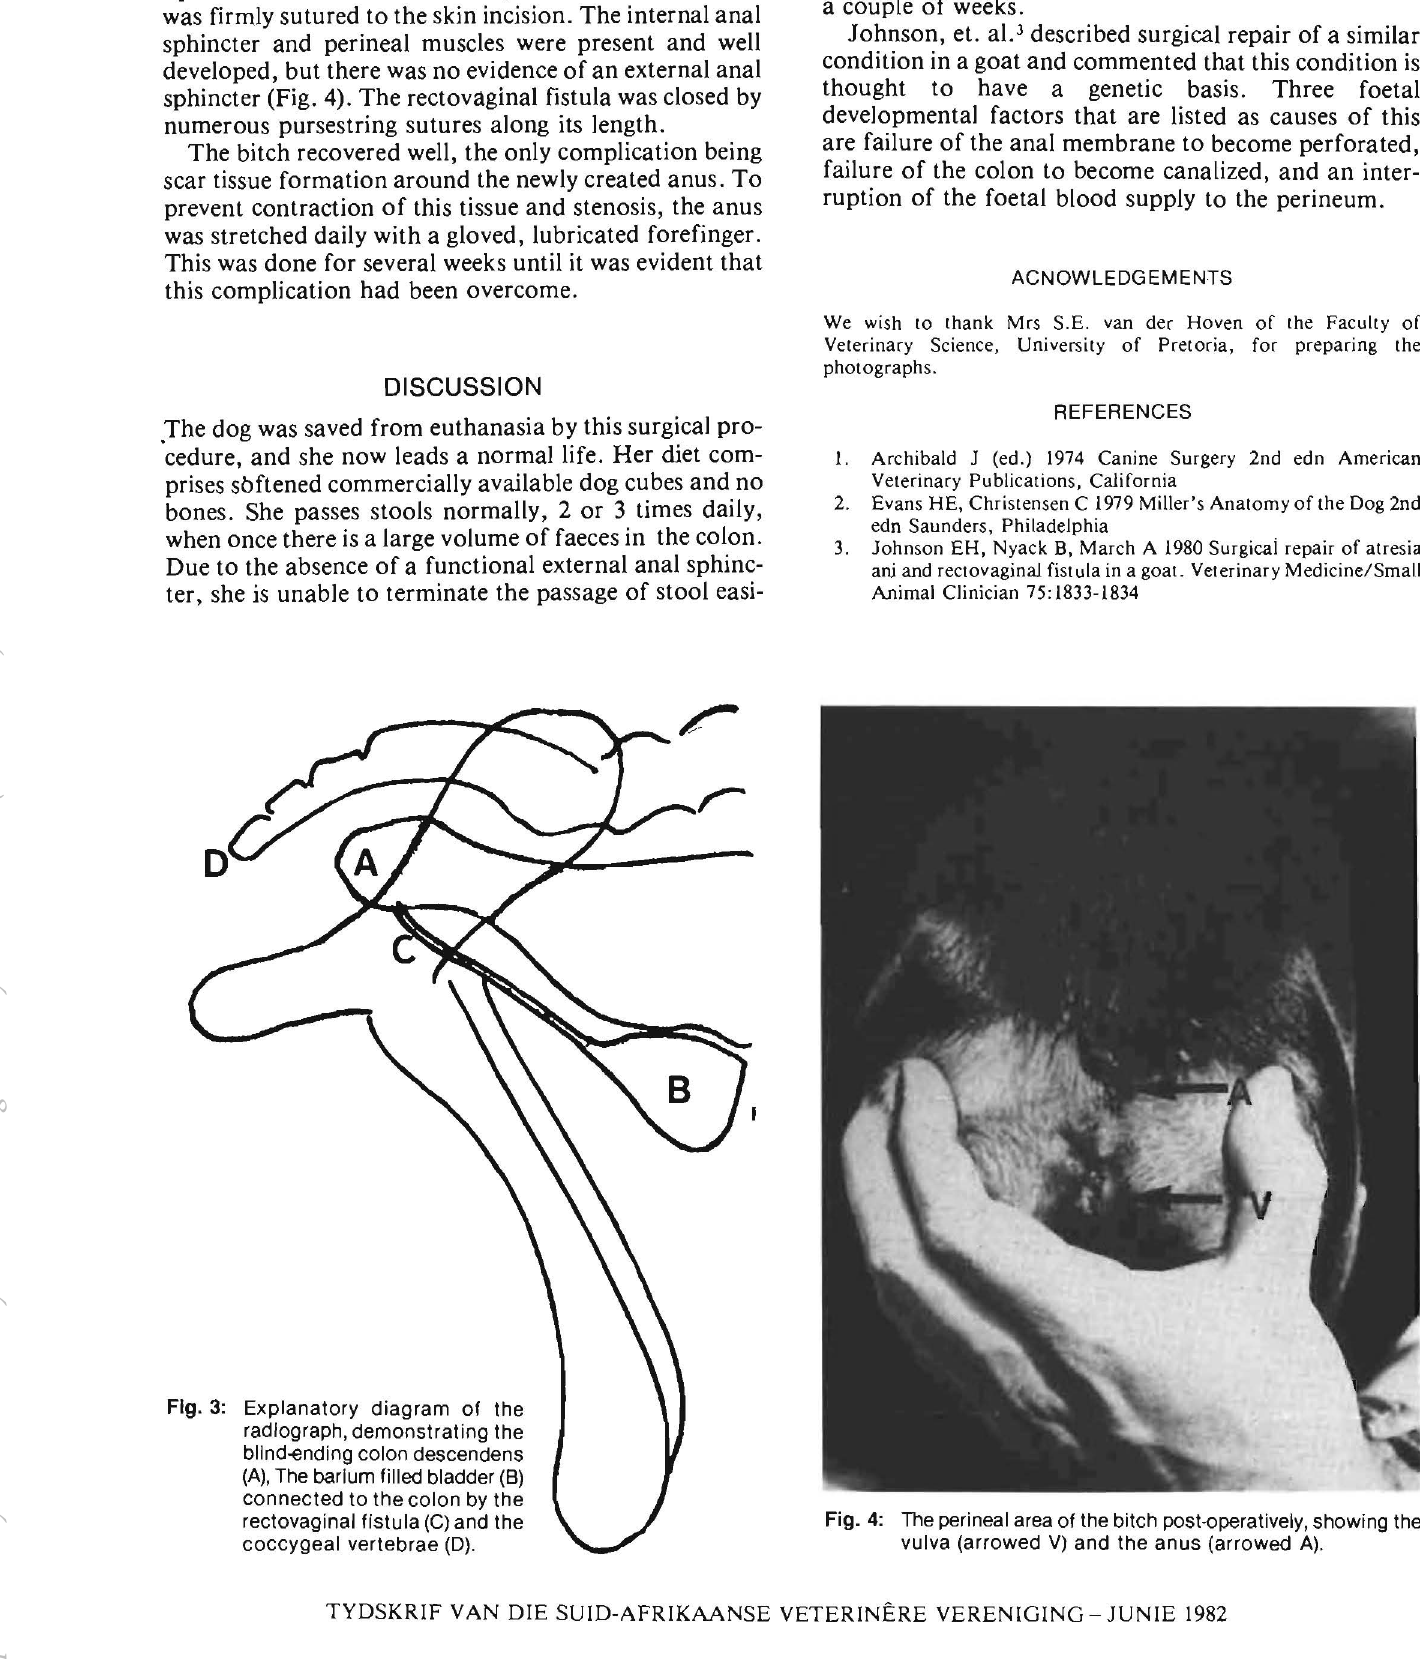
Fig. 4: The perineal area of the bitch post-operatively, showing the vulva (arrowed V) and the anus (arrowed A).